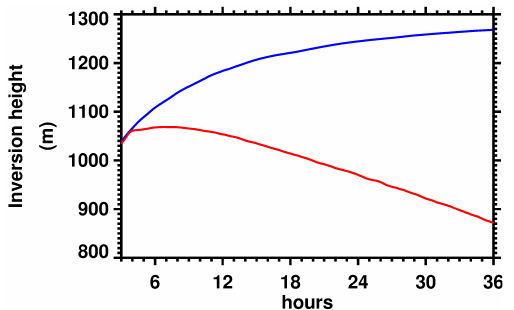
Fig. 5. Domain-averaged inversion height time series in simulation S • (blue) and S ◦